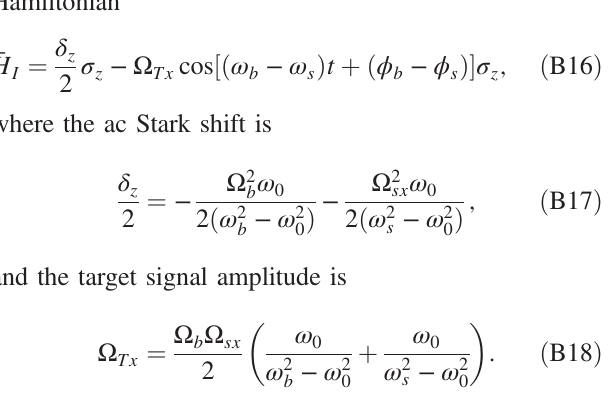
ω ; − ω ; 0 , which is still different from the one given by the b b